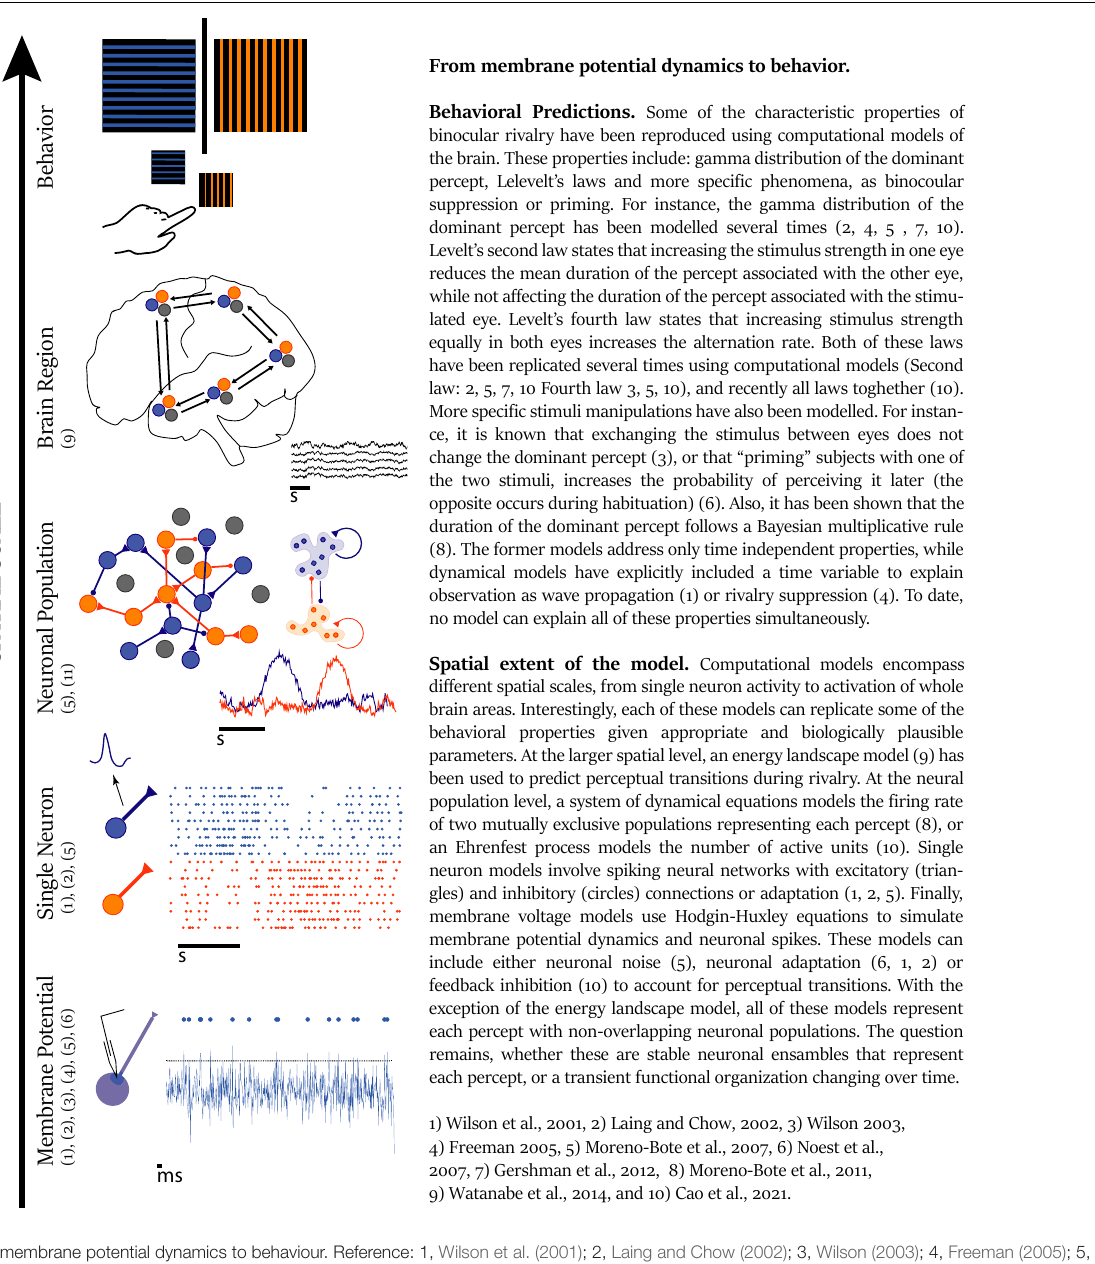
process of perceptual disambiguation and may not be